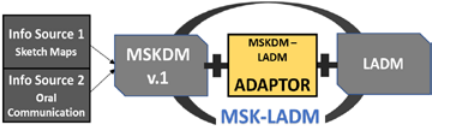
Figure 2. Conceptual integration of MSKDM with